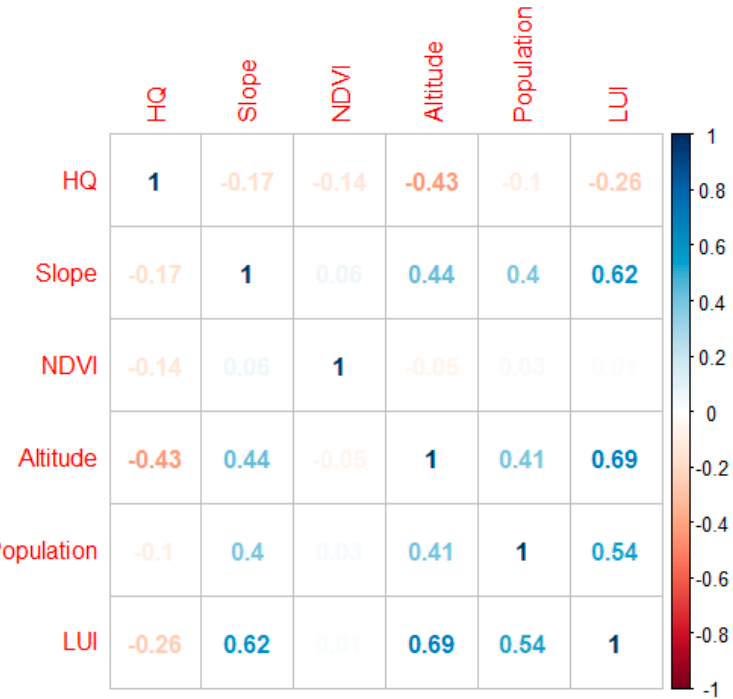
Figure 12. Pearson correlation of habitat quality (HQ: Habitat quality, LUI: Land-use intensity). Table 13. The correlation of impact factors and habitat